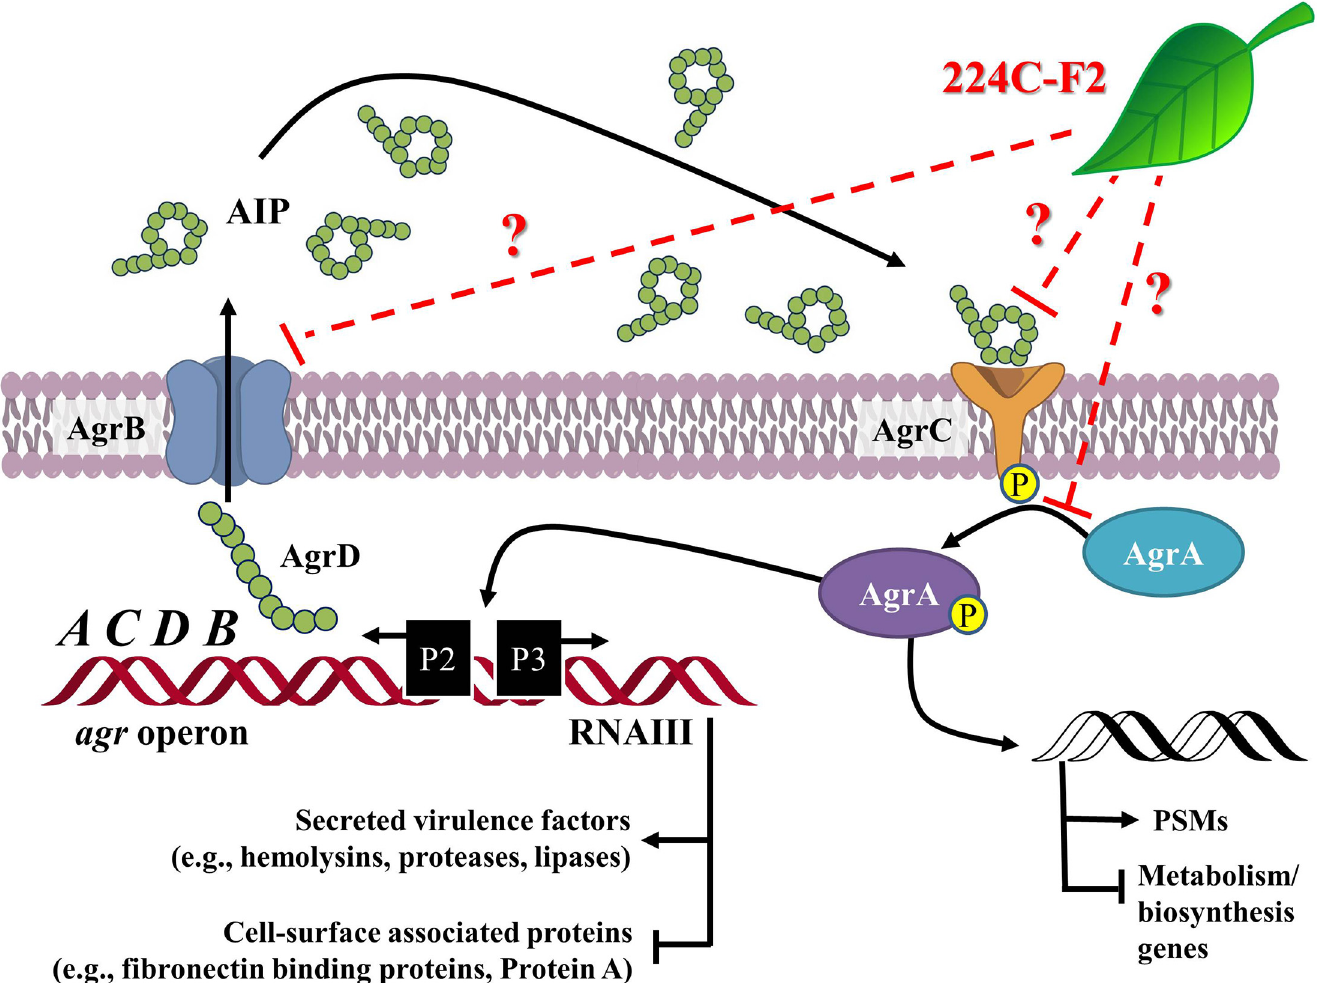
Fig 1. Schematic of the Staphylococcus aureus accessory gene regulator system. The agr locus has been investigated in detail and is known to contain two divergent transcripts named RNAII and RNAIII [9]. The RNAII transcript is an operon of four genes, agrBDCA , that encode factors required to synthesize AIP and activate the regulatory cascade. Briefly, AgrD is the precursor peptide of AIP, AgrB is a membrane protease involved in generating AIP, AgrC is a histidine kinase that is activated by binding AIP, and AgrA is a response regulator that induces transcription of both RNAII and RNAIII. The RNAIII transcript yields a regulatory RNA molecule that acts as the primary effector of the agr system by up-regulating extracellular virulence factors and down-regulating cell surface proteins [65]. The agr pathway is illustrated here with potential target sites for